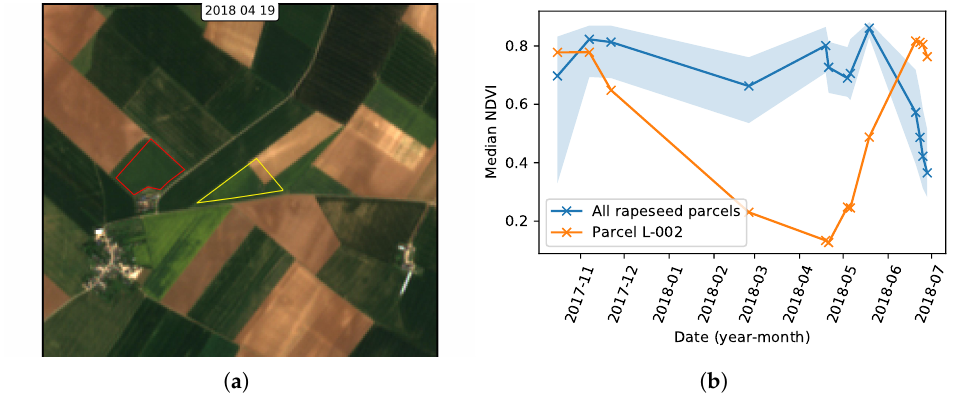
Figure 9. Two examples of error in the parcel contour database ( a ): an error in the parcel delineation is visible (true color S2 image). ( b ): median NDVI time series for a parcel having a wrong crop type